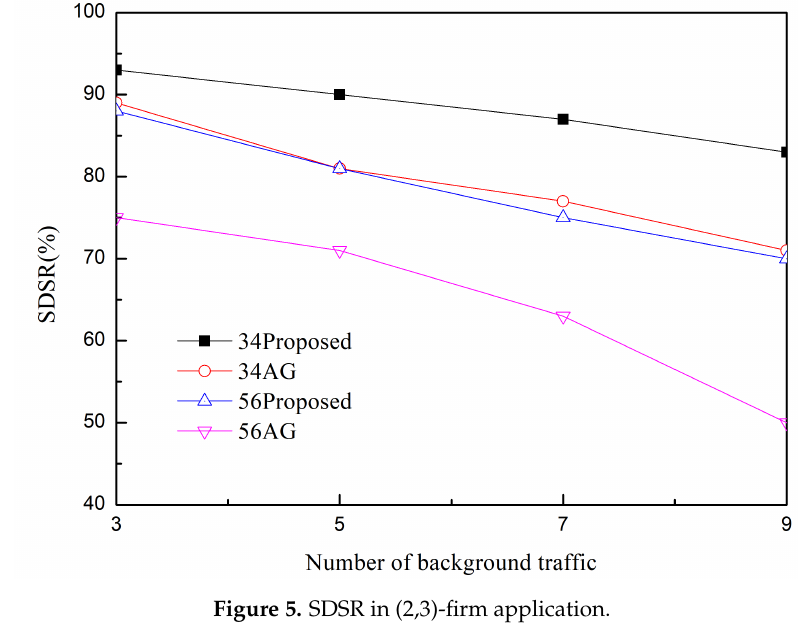
Figure 5. SDSR in (2,3)-firm application.